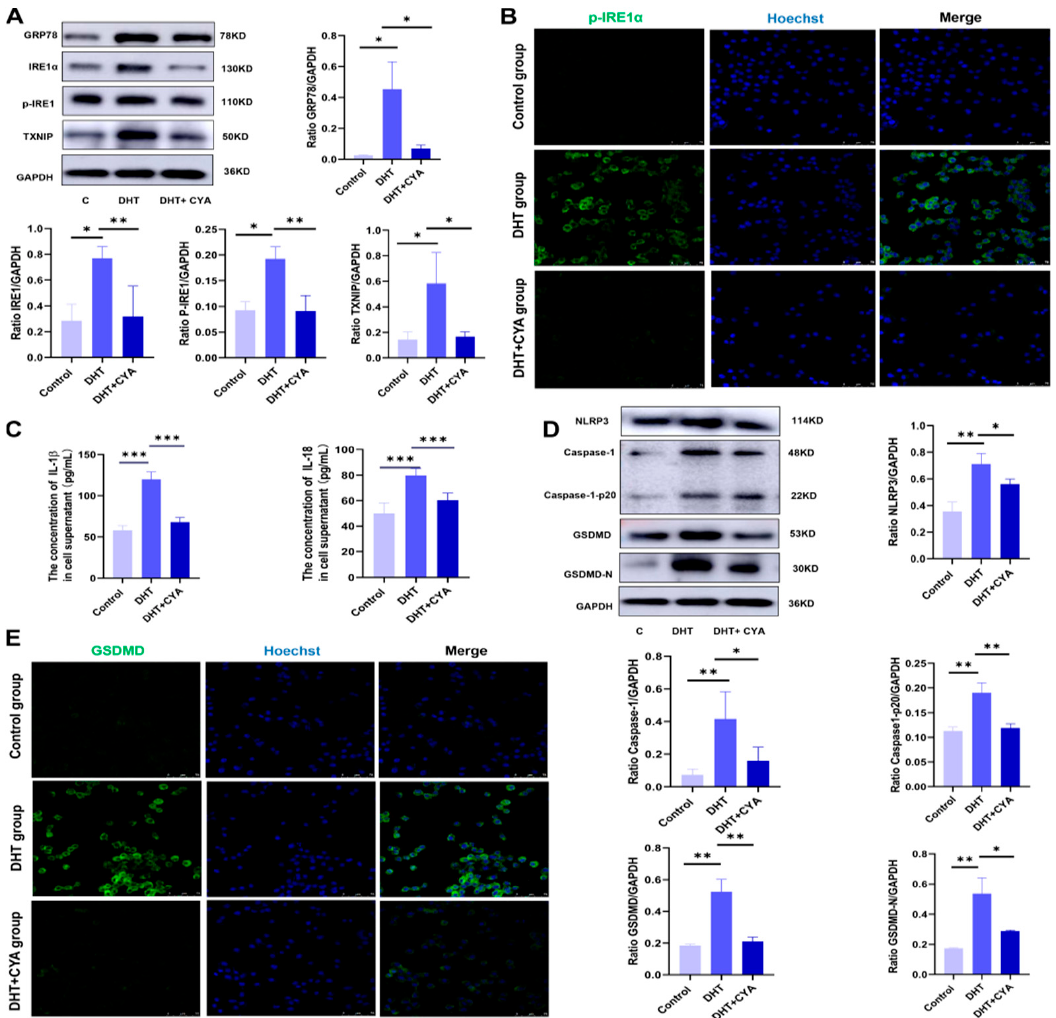
Figure 5. CYA could effectively alleviate the activation of the IRE1 α signaling pathway and pyroptosis in ovarian GCs induced by HA in in vitro experiments. According to the preliminary experiment, the concentration of DHT was 10 uM, the action time was 24 h, and the concentration of CYA was 15 uM. ( a ) The expression of IRE1 α signaling pathway protein in ovarian GCs was assessed with Western blot; ( b ) the expression of p-IRE1 α in ovarian GCs was assessed with immunohistochemical tests; ( c ) the expressions of IL-18 and IL-1 β in cell supernatants were analyzed using enzyme-linked immunosorbent assay kits; ( d ) the expressions of NLRP3 inflammasome and pyroptosis-related proteins in ovarian GCs were assessed with Western blot; ( e ) the expression of GSDMD in ovarian GCs was assessed with immunohistochemical tests. Two independent experi- ments were performed with similar results. Data are shown as mean ± SEM. * p < 0.05, ** p < 0.01, *** p < 0.001.